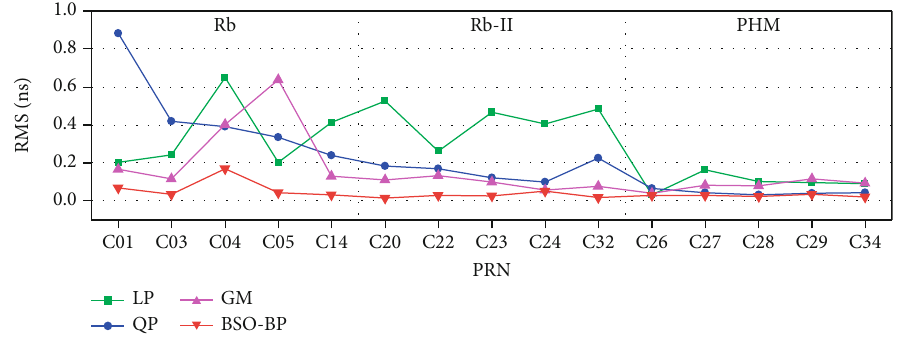
Figure 6: The prediction accuracy of 15 BDS satellites for 0.5 hours using 6 hours SCB data.